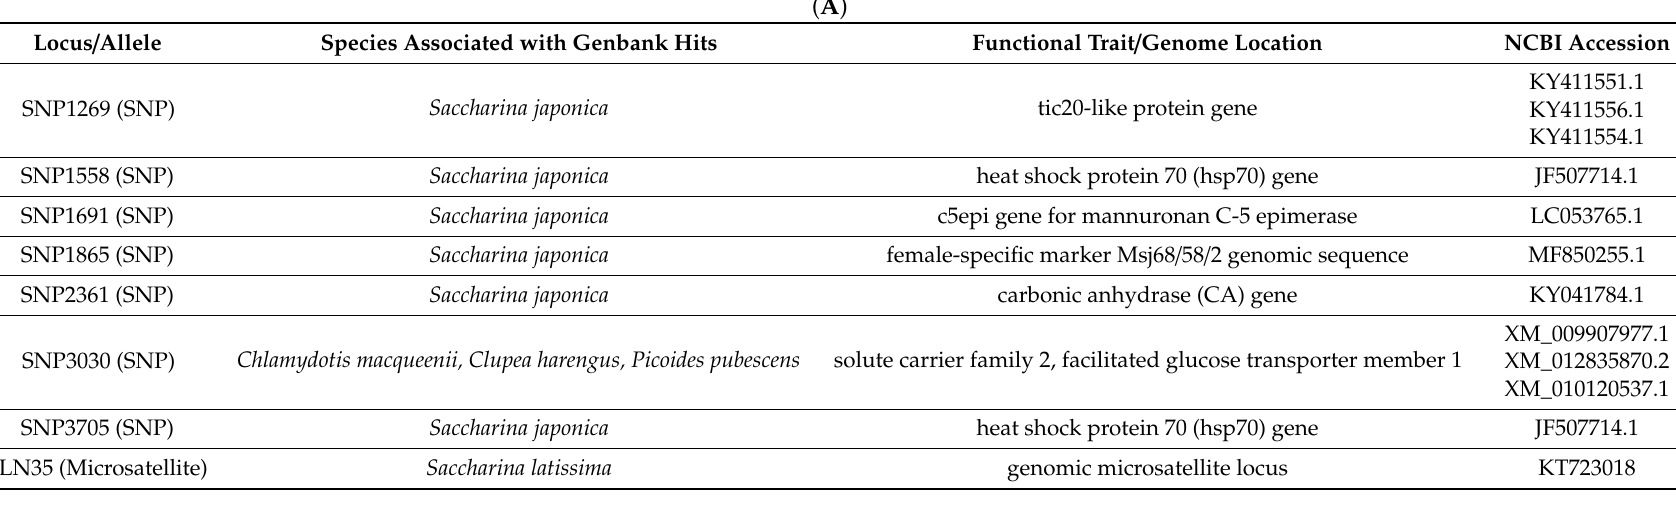
Table 2. Putative outlier loci displaying significant correlations with 12 environmental parameters. ( A ) Candidate outlier SNP and SSR markers associated with the hierarchical population structure of S . latissima . ( B ) Candidate outlier SNP markers that correlated significantly with 12 environmental parameters in the pairwise comparison tests (* = candidate outlier markers associated with the hierarchical population structure of S . latissima